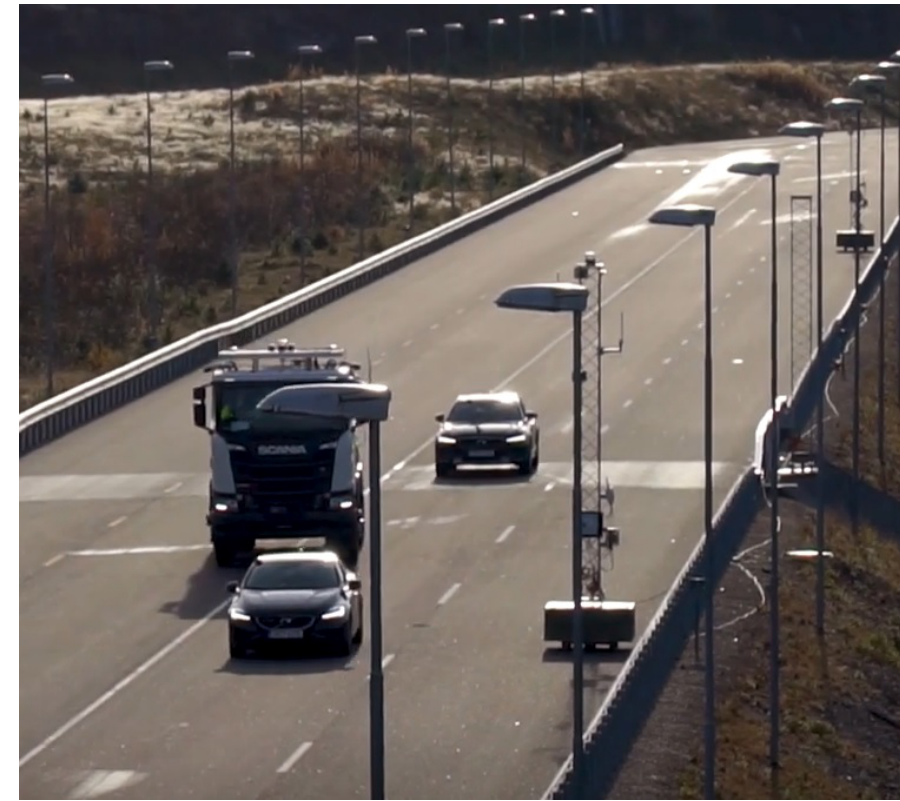
Figure 7. PRoPART scenario.